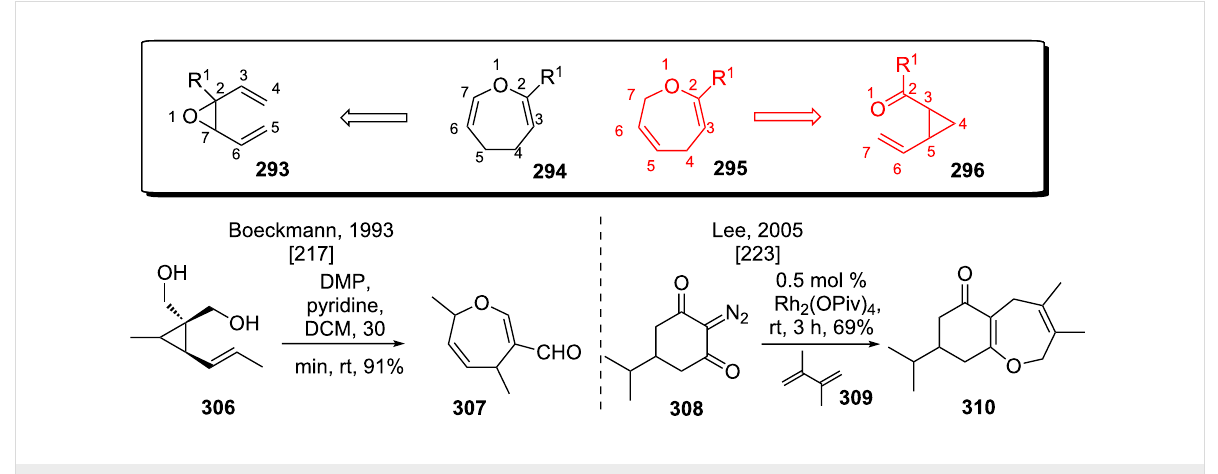
Scheme 37: Studies on the vinylcyclopropanecarbonyl rearrangement.